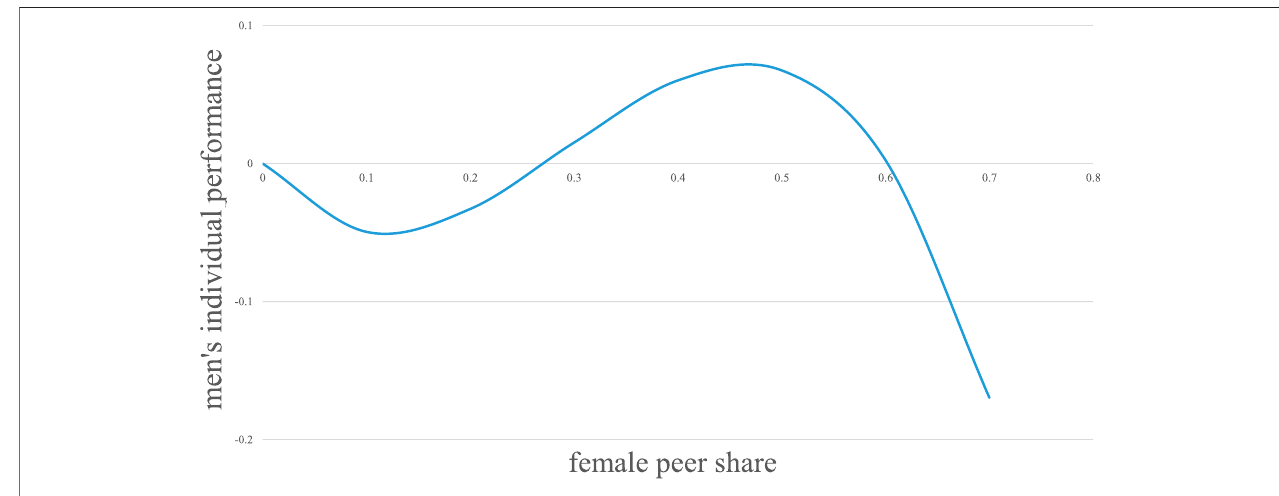
FIGURE 1 | Cubic regression results for individual performance and female peer share for men.